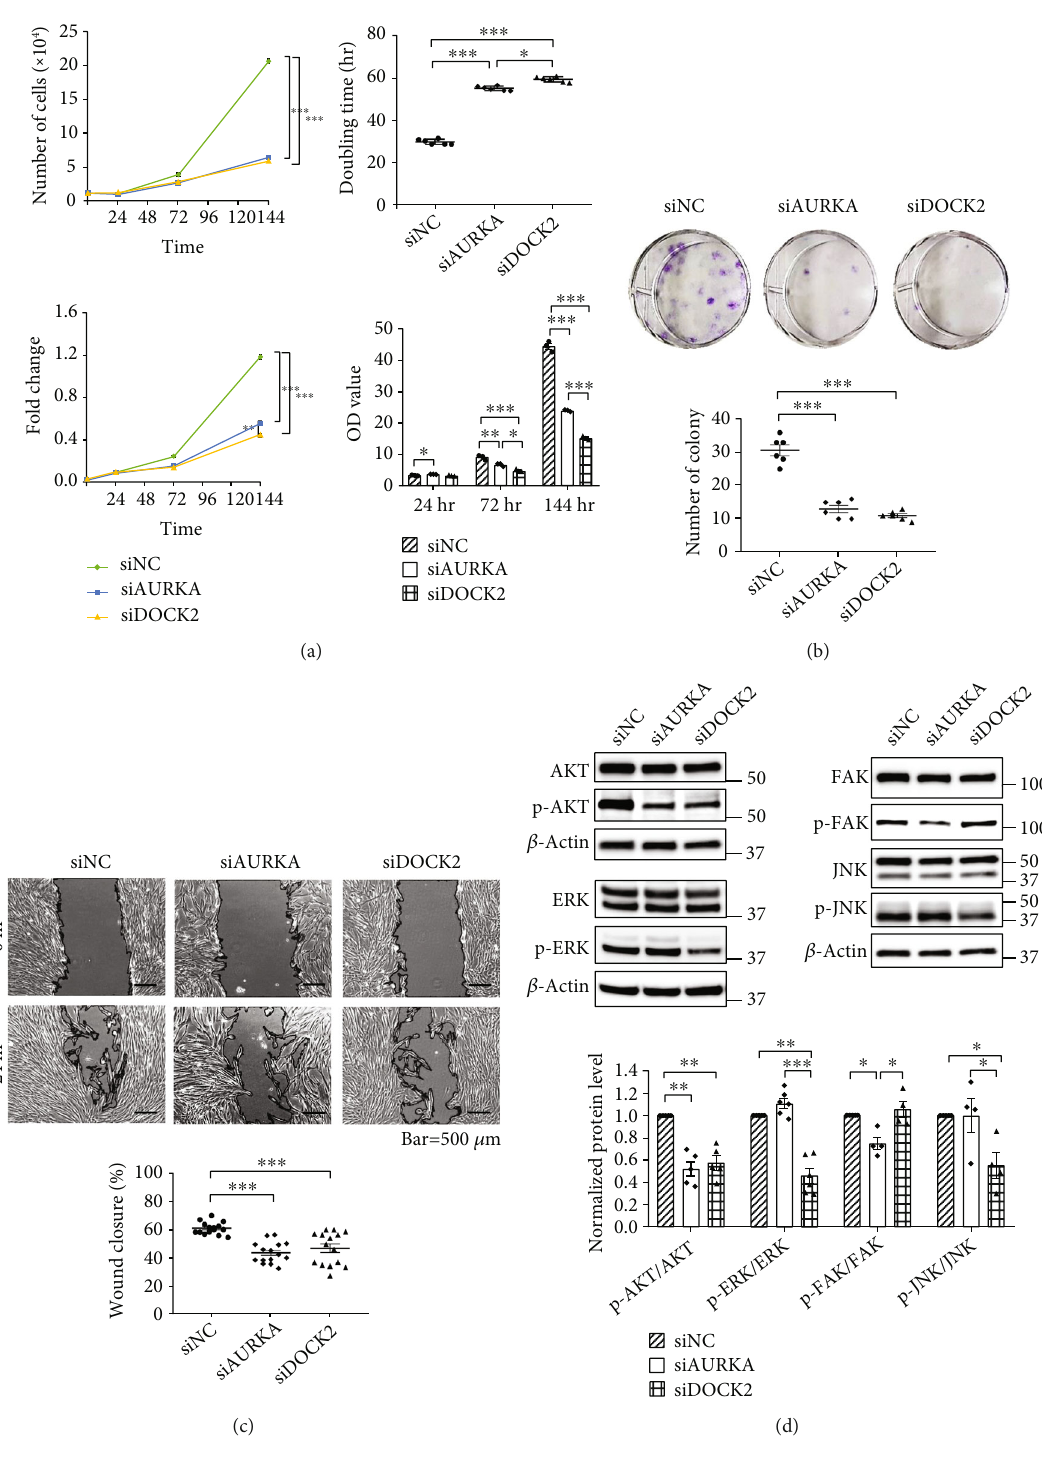
Figure 2: Knockdown of AURKA and DOCK2 inhibited cell proliferation, colony formation, and migration of WJ-MSCs. (a) Proliferation was evaluated by cell counting and CCK-8 assay at 0, 24, 72, and 144h after seeding the siRNA-transfected cells. (b) Colony formation assays were performed in triplicate, with 1,000 cells per well to start with. Colonies were stained and counted two weeks after plating. (c) Migration was examined by wound healing assay. Knockdown of AURKA and DOCK2 inhibited the migration of WJ-MSCs. (d) Downregulation of AURKA inhibited phosphorylation of AKT and FAK while that of DOCK2 inhibited phosphorylation of AKT, ERK, and JNK. Normalized protein level indicates the value converted based on the siNC group. Data are shown as means ± SEM . One-way ANOVA with Dunnett ’ s multiple comparison test (b – d), and Tukey ’ s multiple comparisons test (a). ∗∗∗ p < 0 : 001 , ∗∗ p < 0 : 01 , and ∗ p < 0 : 05